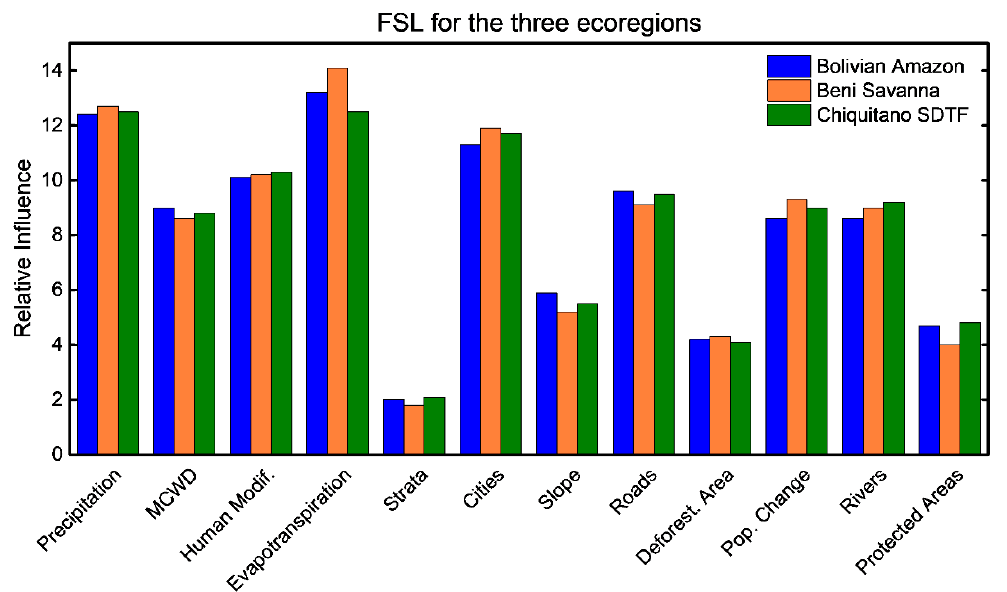
Figure 5. The relative influence (%) estimated by Boosted Regression Tree models of different variables on Active Fire Density (AFD) for each ecoregion modelled (Precip = annual precipitation; maximum cumulative water deficit (MCWD).